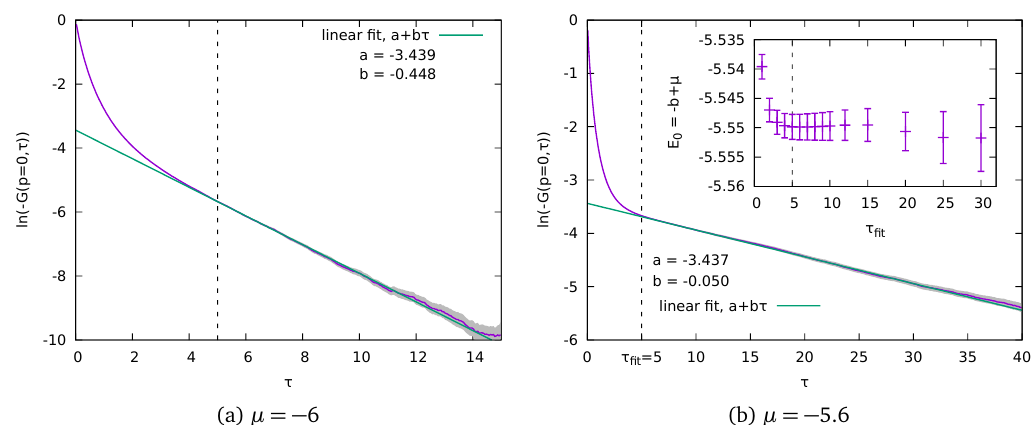
Figure 9: Logarithm of the Green function ln ( − G ( p = 0, τ )) as a function of imaginary time τ for α = 5 and different values of µ . Error bars are indicated by the shaded area. The = 5 in order to obtain the exponential decay of the Green function is fitted starting from τ fit polaron ground state energy and its residue, cf. Eq. 21. The inset in panel (b) shows the polaron energy (computed from the slope of the fit) for different fit windows [ τ ,40 ] . Error fit bars on these data have been obtained by considering 28 independent simulations. One can = 5 is sufficiently great to probe the asymptotic regime. We switched off the see that τ fit CHANGE-P update and used a uniform grid in the τ -direction. The code ran for 36 (a) and 467 (b) CPU-hours with the number of updates totalling 10 12 and 10 13